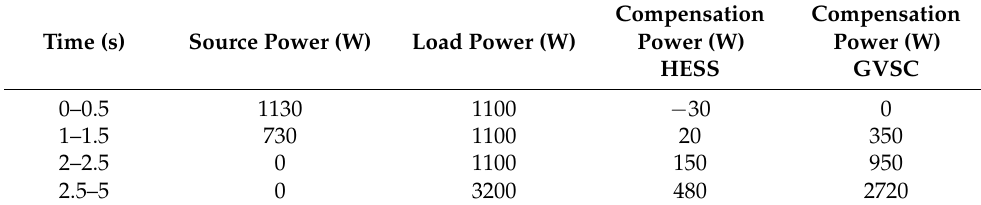
Table 3. Mode of operation 2.